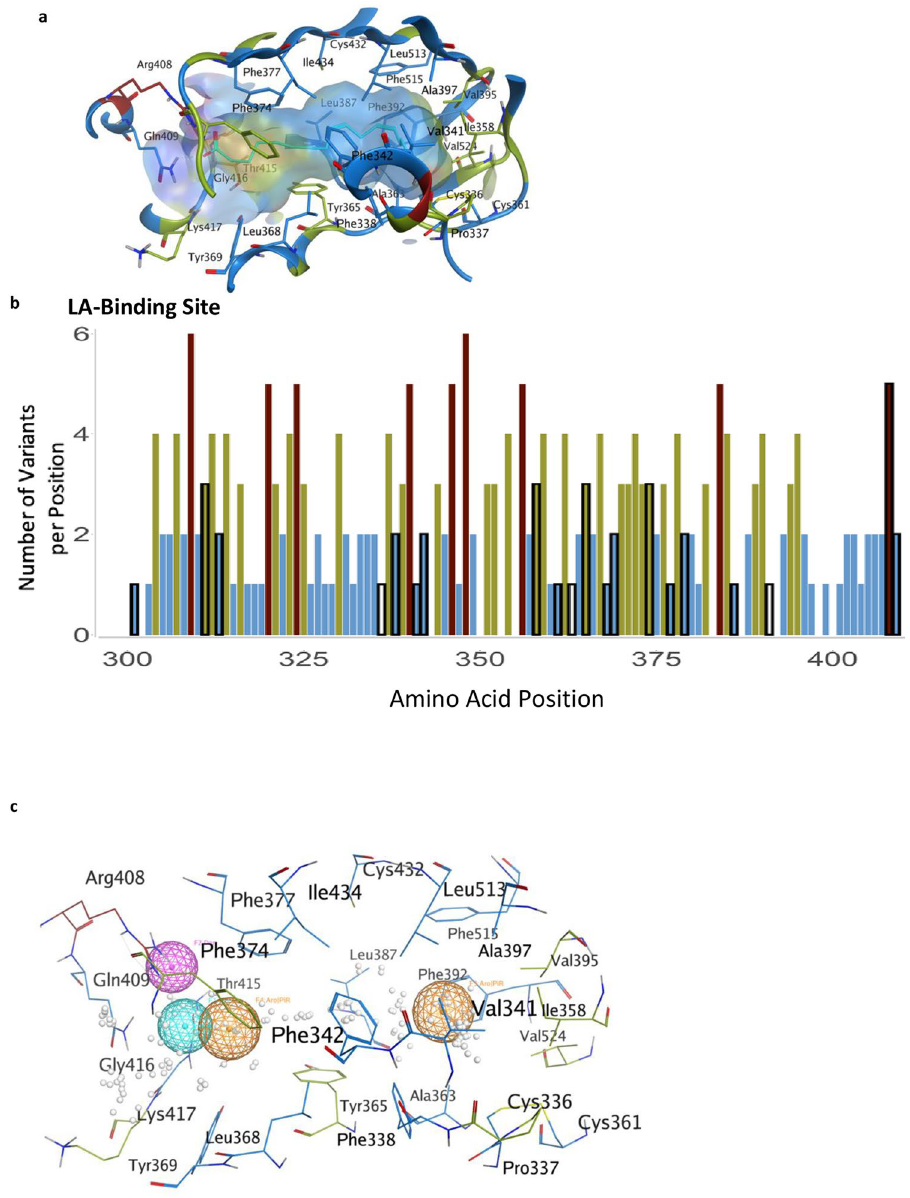
Figure 3. The LA-binding site in the S protein. ( a ) Hydrophobic pocket forms the LA-binding site. Residues are colored by the number of observed variants per position using the same color scheme as previous figures. ( b ) The number of variants per position across the LA-binding site; black outlines indicate the positions that form the LA-pocket. ( c ) Pharmacophore of the LA-binding pocket. Orange spheres indicate aromatic or pi-rings. The magenta sphere indicates hydrogen bond donors. The cyan sphere indicates hydrogen bond acceptors. White dots represent dummy atoms in the